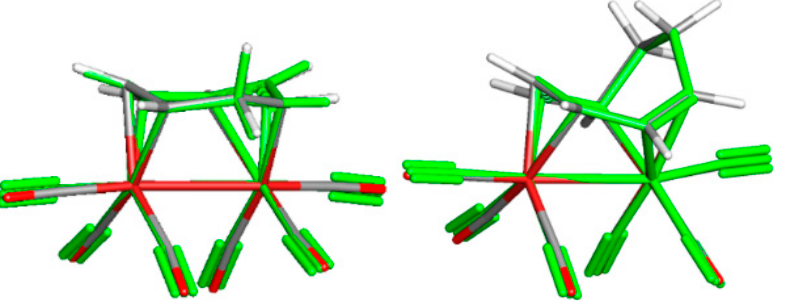
Figure 1. Overlaid structures of the X-ray crystal (green) and optimized structures of (C 7 H 8 )Fe 2 (CO) 6 (left) and (C 8 H 10 )Fe 2 (CO) 6 (right). Color code: red, Fe; gray, C; red, O; white, H.